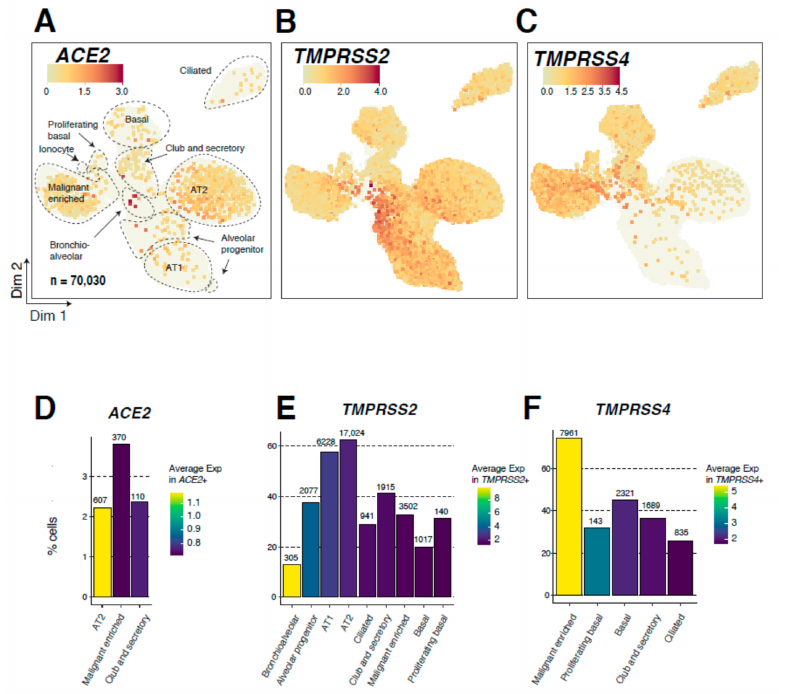
Figure 2. Single-cell expression analysis of ACE2, TMPRSS2 , and TMPRSS4 in 70,030 lung epithelial cells. ( A – C ) Uniform Manifold Approximation and Projection (UMAP) plots showing epithelial subclusters and expression of ACE2 ( A ), TMPRSS2 ( B ), and TMPRSS4 ( C ) in epithelial subclusters. Cells are colored by the expression level of each gene. AT1: alveolar type 1 cells; AT2: alveolar type 2 cells. ( D – F ) Bar plots showing the fraction of cells (percentage of each subcluster) expressing ACE2 ( D ), TMPRSS2 ( E ), and TMPRSS4 ( F ) among airway lineage clusters with the highest fractions of cells positive for each gene (2% cutoff applied). The absolute number of cells positive for each gene and within each analyzed subcluster are indicated on top of the corresponding bars. Color indicates average expression in cells positive for the gene of